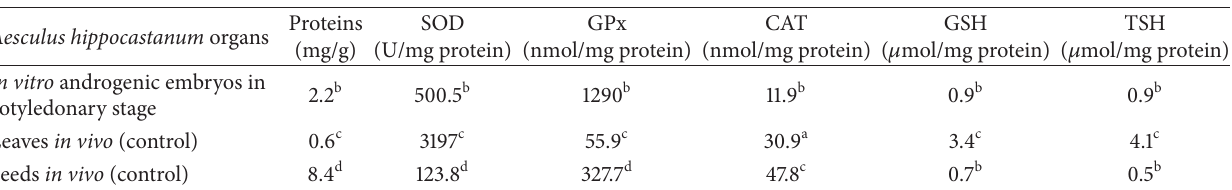
Seeds in vivo (control) Values in rows marked with different letters (a, b, c, and d) were significantly different according to Duncan 𝑡 -test 𝑃 < 0.05 . For each parameter, experiments and measurements were also recorded in triplicate; SOD: superoxide dismutase; GPx: glutathione peroxidase; CAT: catalase; GSH: reduced glutathione; TSH: total